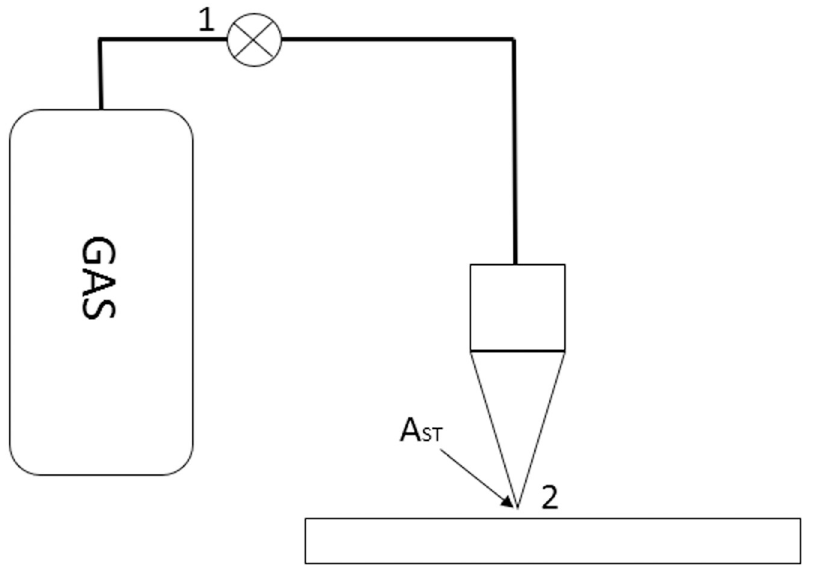
Fig 3. Representation of gas delivery in laser cutting